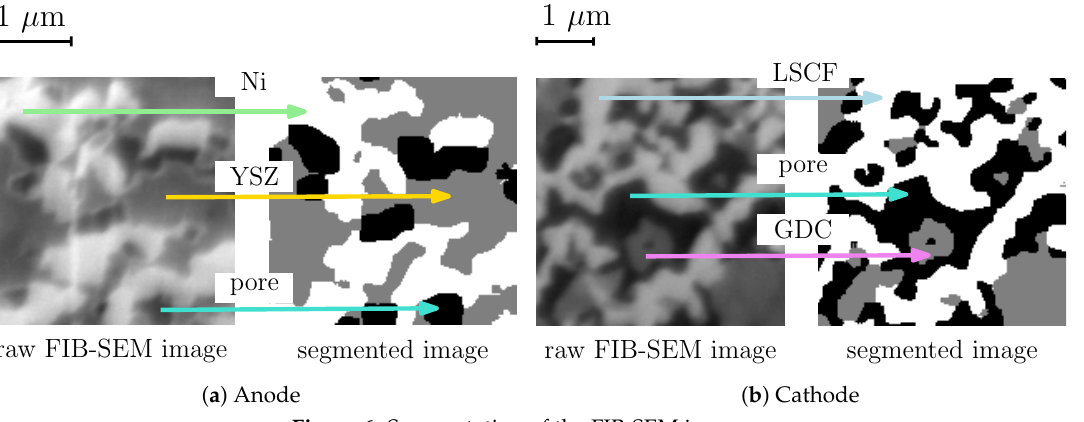
raw FIB-SEM image Figure 6. Segmentation of the FIB-SEM